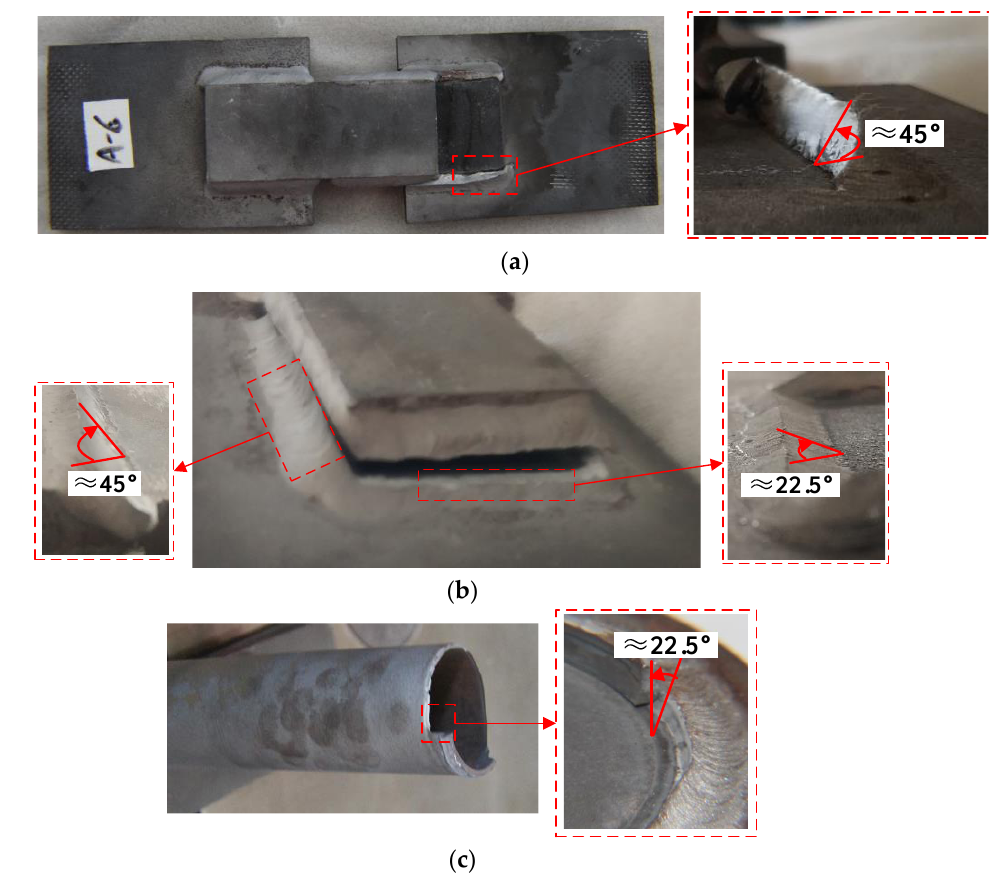
Figure 11. Failure fractures of the welded specimens: ( a ) standard shear specimen; ( b ) U-shaped fillet welded specimen; ( c ) pipe-plate fillet welded specimen.